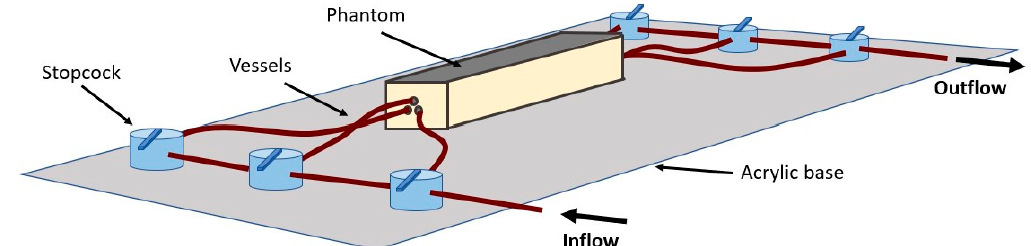
Figure 3. Illustration of the assembled phantom connected to the distribution network fixed on an acrylic sheet.